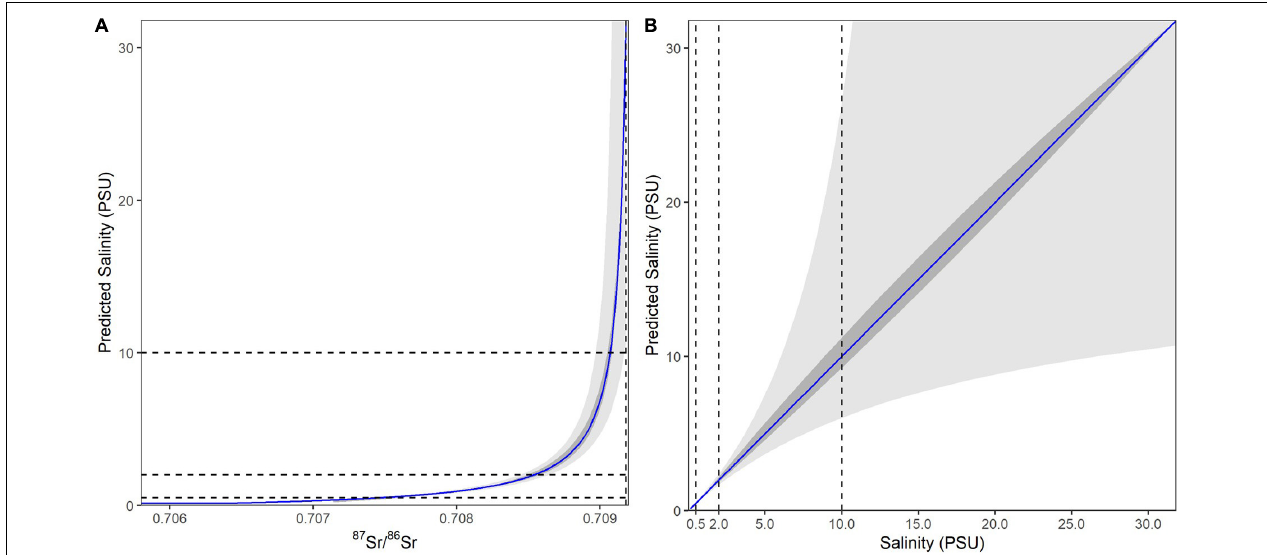
FIGURE 3 | The 87 Sr/ 86 Sr to salinity mixing model based on Hobbs et al. (2019). (A) The 87 Sr/ 86 Sr to salinity relationship across the 87 Sr/ 86 Sr values for the entire SFE. Blue line representing the 70-30 Sacramento to San Joaquin River freshwater endmember and the inner gray band representing the uncertainty introduced by varying between 100% Sacramento and 100% San Joaquin River water. The outer gray band represents the uncertainty introduced into predicted salinities based on the propagated uncertainties from the geochemical analyses. (B) The relationship between predicted versus measured salinity values, showing that prediction uncertainty increases asymmetrically with salinity. Dashed lines show the 0.5, 2, and 10 salinity cutoffs used to identify different habitats. Note that due to these increasing uncertainties salinities > 10 psu were treated here as “high salinity” and include salinity values from 10 to 32 (seawater).